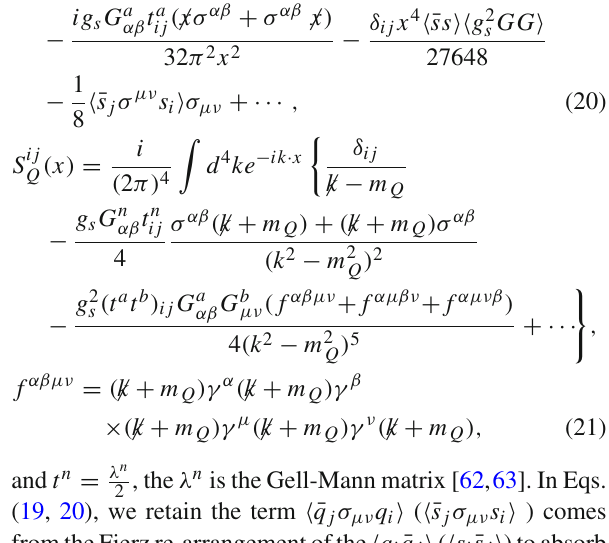
from the Fierz re-arrangement of the (cid:8) q i ¯ q j (cid:9) ( (cid:8) s i ¯ s j (cid:9) ) to absorb the gluons emitted from other quark lines to extract the mixed condensate (cid:8)¯ qg s σ Gq (cid:9) ( (cid:8)¯ sg s σ Gs (cid:9) ). For the correlation functions (cid:12)( p ) and (cid:12) μν ( p ) of the doubly heavy three-quark currents, there are two heavy quark propagators and a light quark propagator, if each heavy quark line emits a gluon and each light quark line contributes a quark pair, we obtain a operator GG ¯ qq (or GG ¯ ss ), which is of dimension 7, for example,